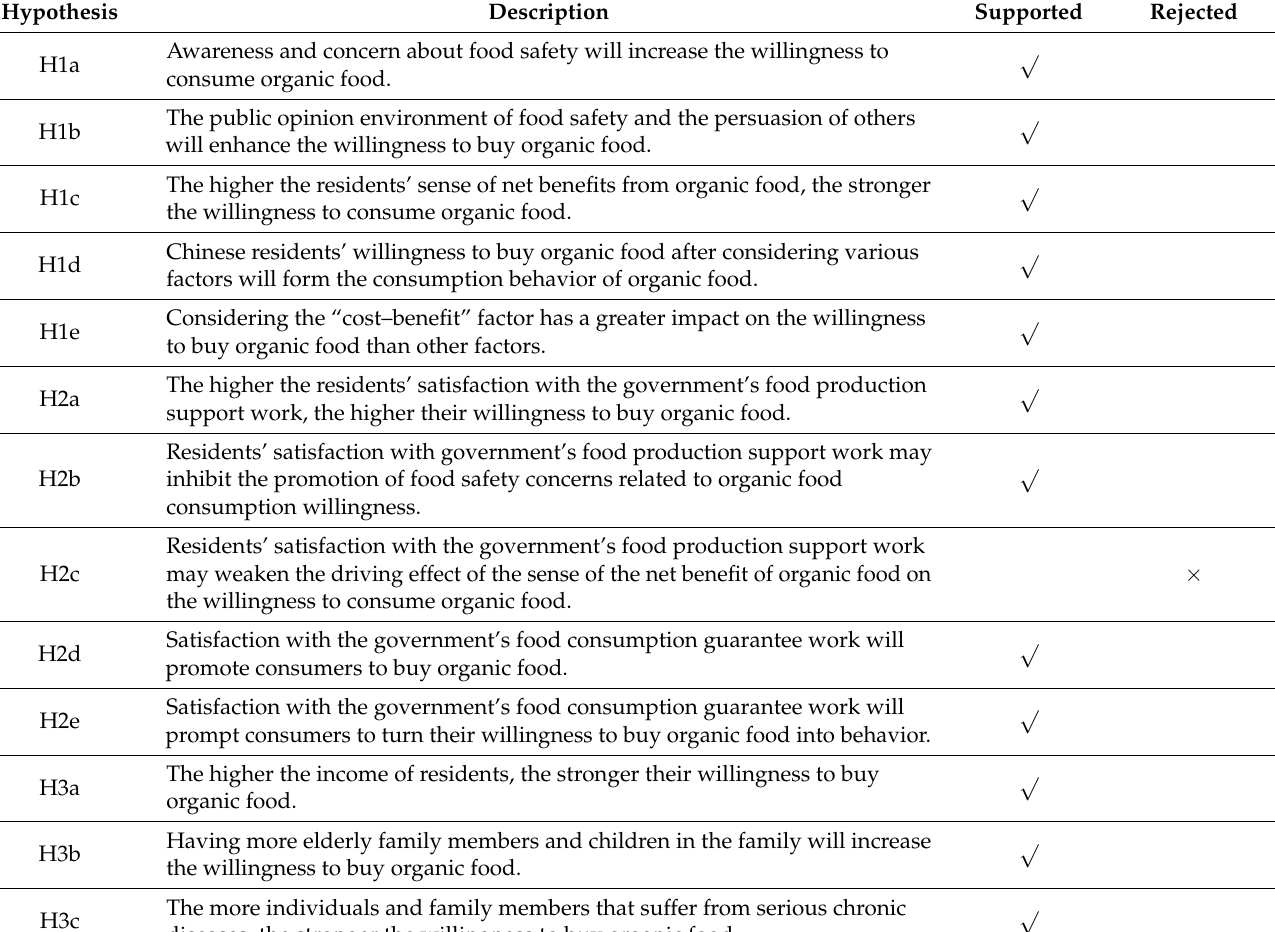
Table 6. Confirmed